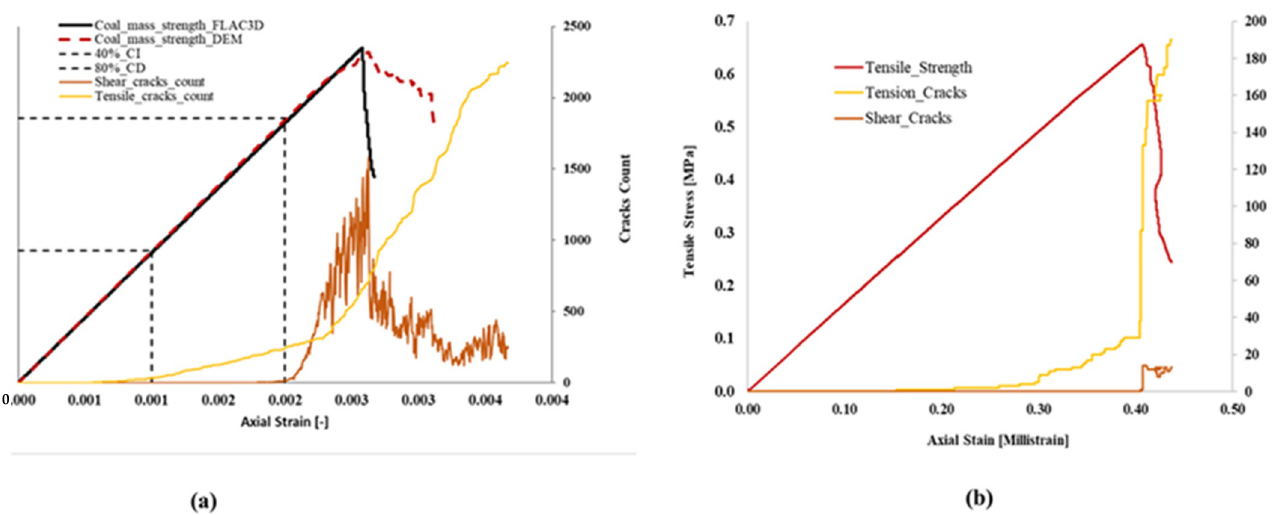
Figure 7. ( a ) The coal mass uniaxial compressive ( b ) and tensile tests, comparing the results from the coal mass model in FLAC3D and the simulated stress–strain curves in UDEC. Also included is the crack–strain curves for the coal mass.